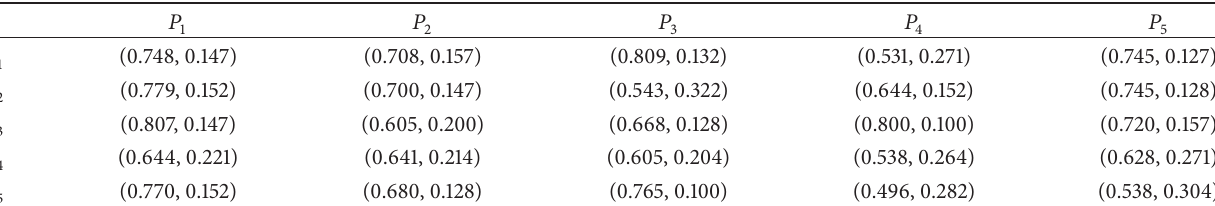
Table 6: Intuitionistic fuzzy decision matrix 𝑅 󸀠